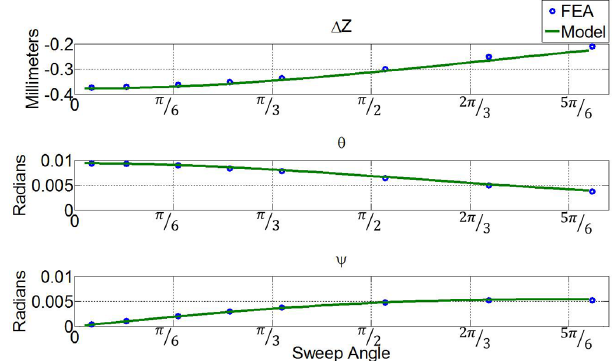
Figure 7. Comparison of the FEA and closed-form equation calcu- lations of the curved beam displacements vs. sweep angle, φ , for a cantilever beam, K 1. Max error between models is 7%. ∆ z repre- sents the desired motion along the z-axis of the beam as indicated in Fig. 2b. θ and Ψ correspond to the two parasitic rotations of the beam under a load normal to the plane of curvature. Flexure length is held constant by varying the radius of curvature.